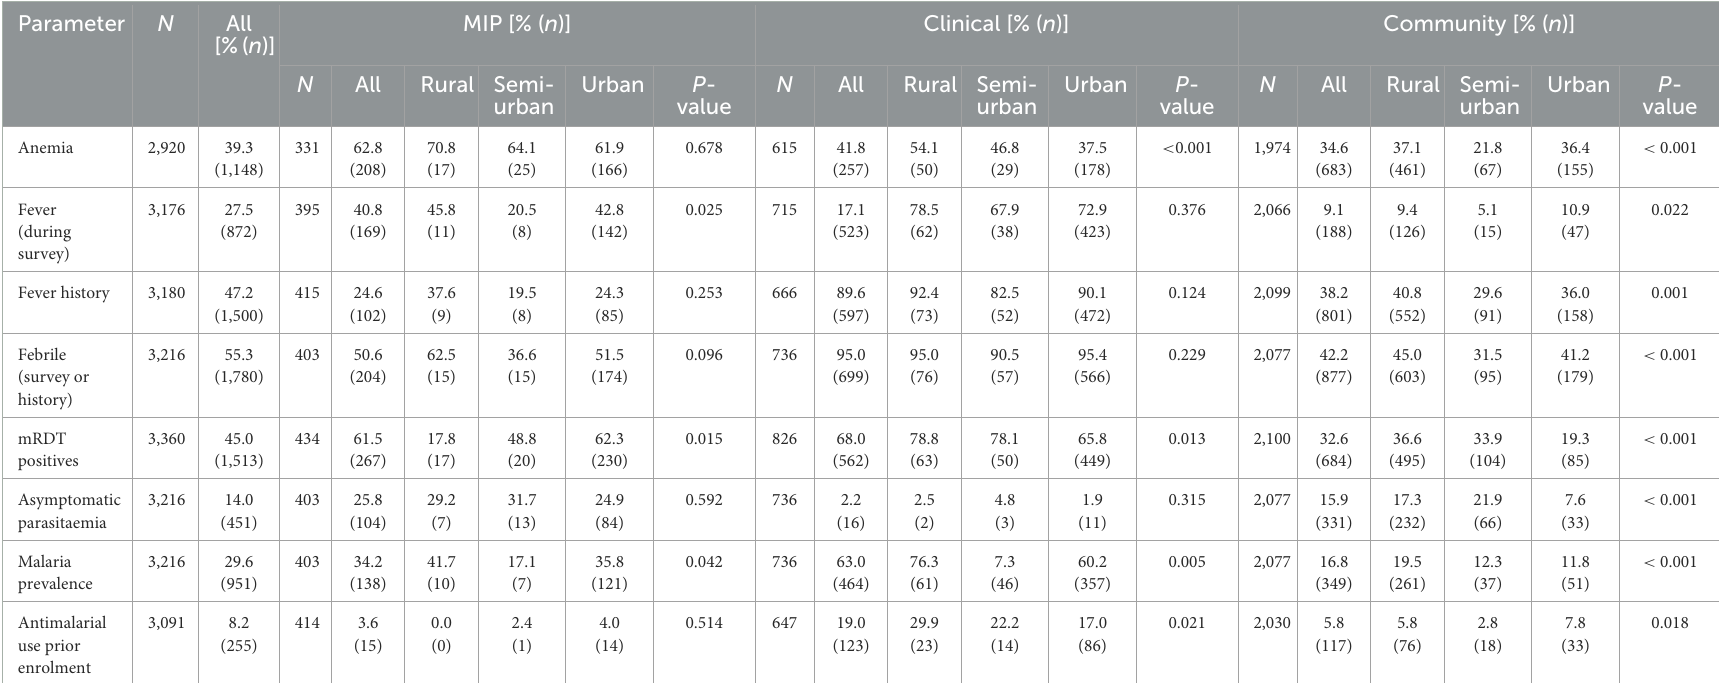
TABLE 3 Clinical characteristics of the study population.